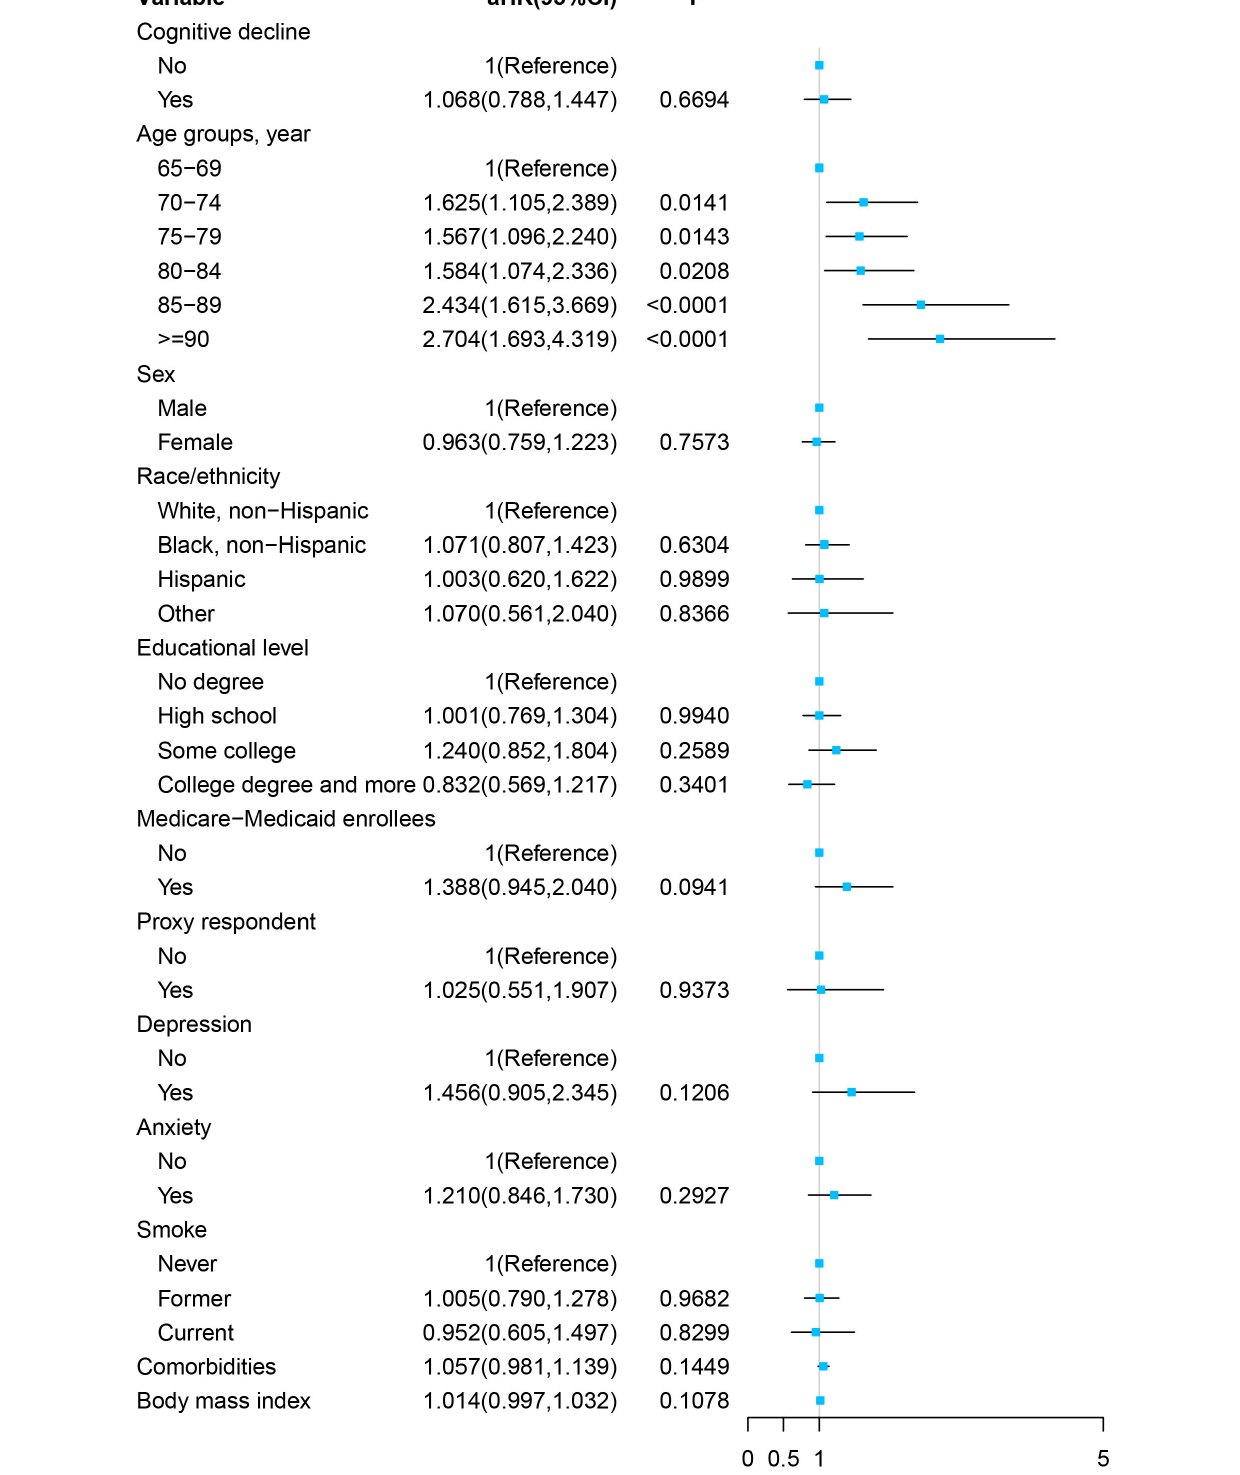
Frontiers in Public Health |